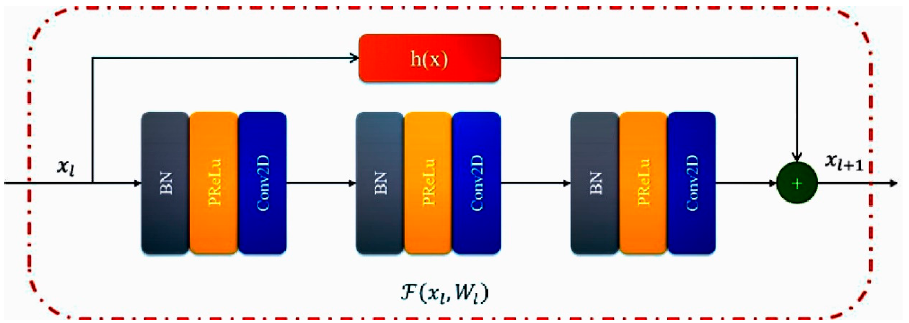
Figure 4. Residual unit used in this paper.